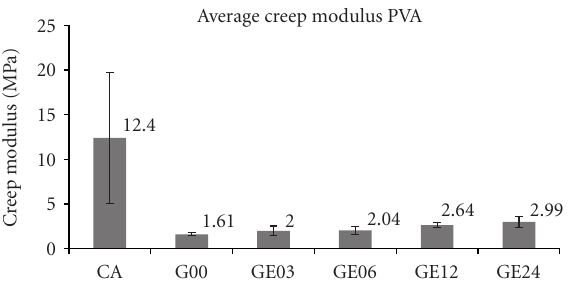
Figure 4: Average creep modulus and respective standard deviations for the rat articular cartilage (CA), control group (G00), and the experimental groups (EGs) according to follow-up time. Confidence level ( P < 0 . 05) was obtained through Anova multiple comparison analysis